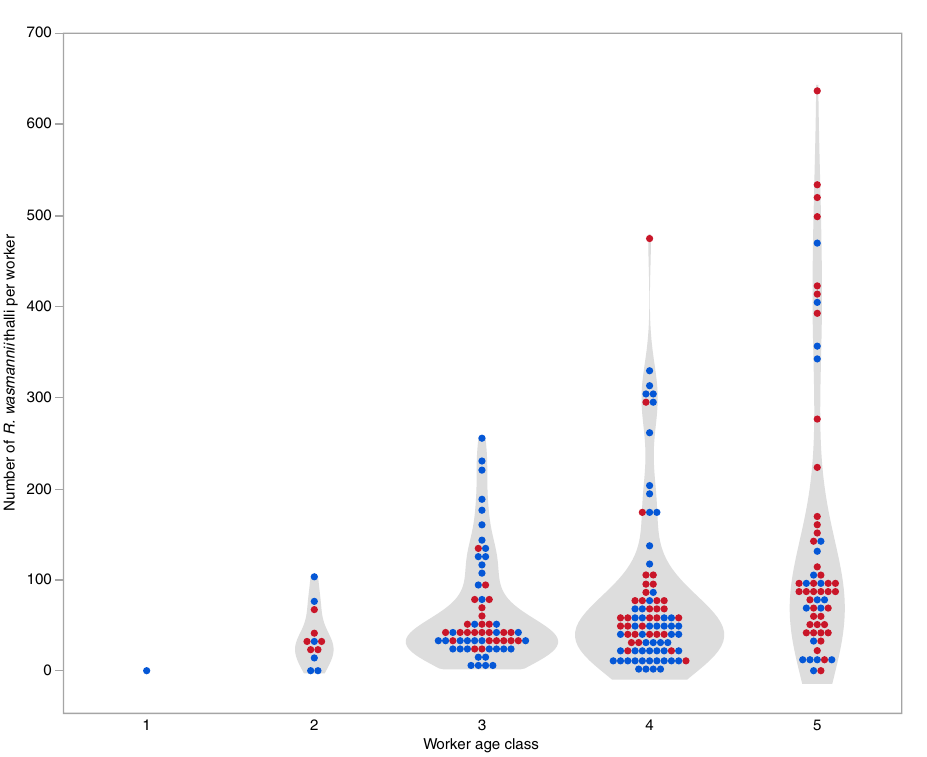
Figure 7. Violin plot with superimposed raw values showing the number of thalli of Rickia wasmannii found on workers of Myrmica scabrinodis of different ages. Red points represent workers sampled from colonies with Phengaris alcon caterpillars present, while blue points are from unparasitized